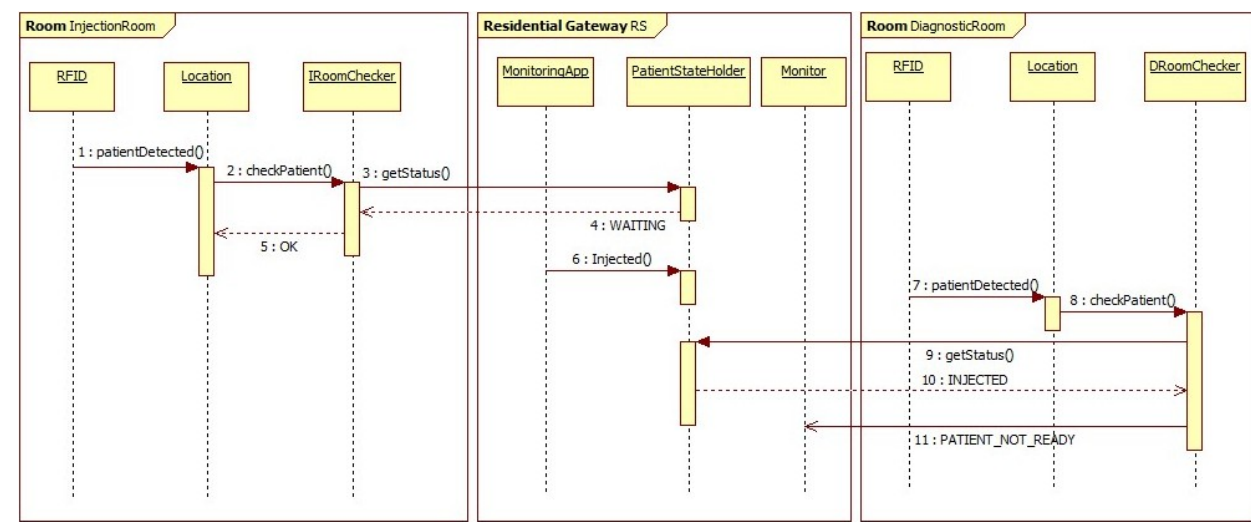
Figure 5. Component